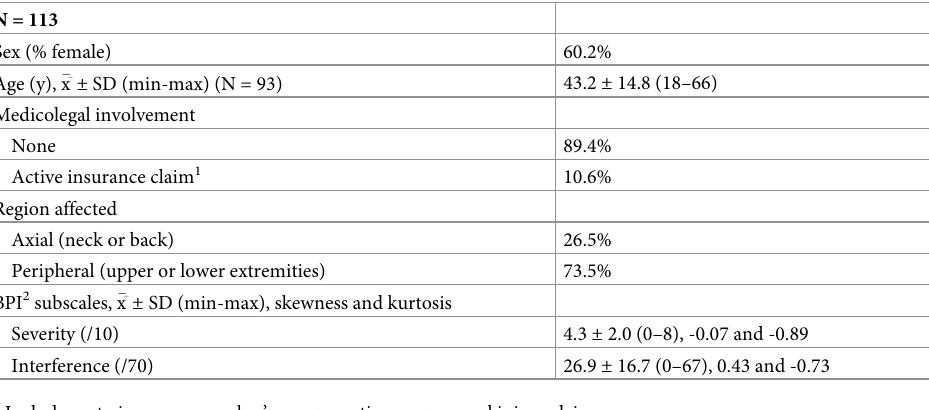
Table 1. Characteristics of the study